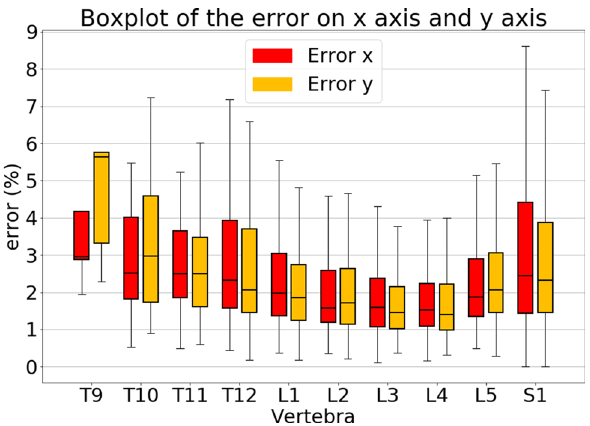
Figure 5. Boxplot of the absolute errors for x (in red) and y (in orange) axis. The errors are in percentage and are relative to the x and y dimension of the vertebra (width and height). (Eqs. 1 and 2).